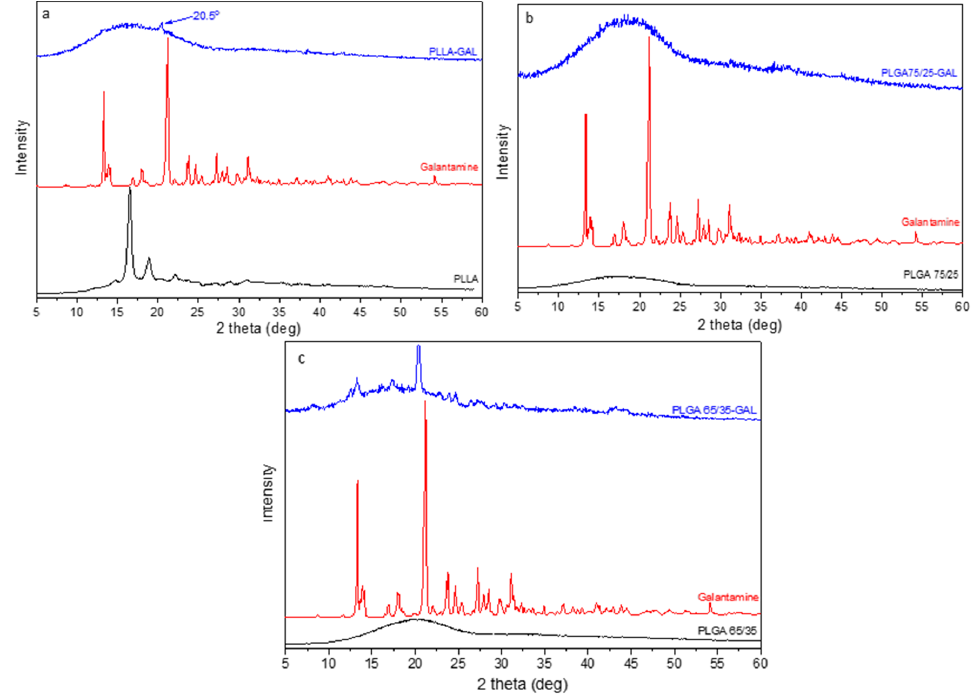
Figure 8. XRD patterns of neat polymers and their nanoparticles with galantamine. ( a ) PLLA–GAL, ( b ) PLGA 75/25–GAL, and ( c ) PLGA 65/35–GAL.